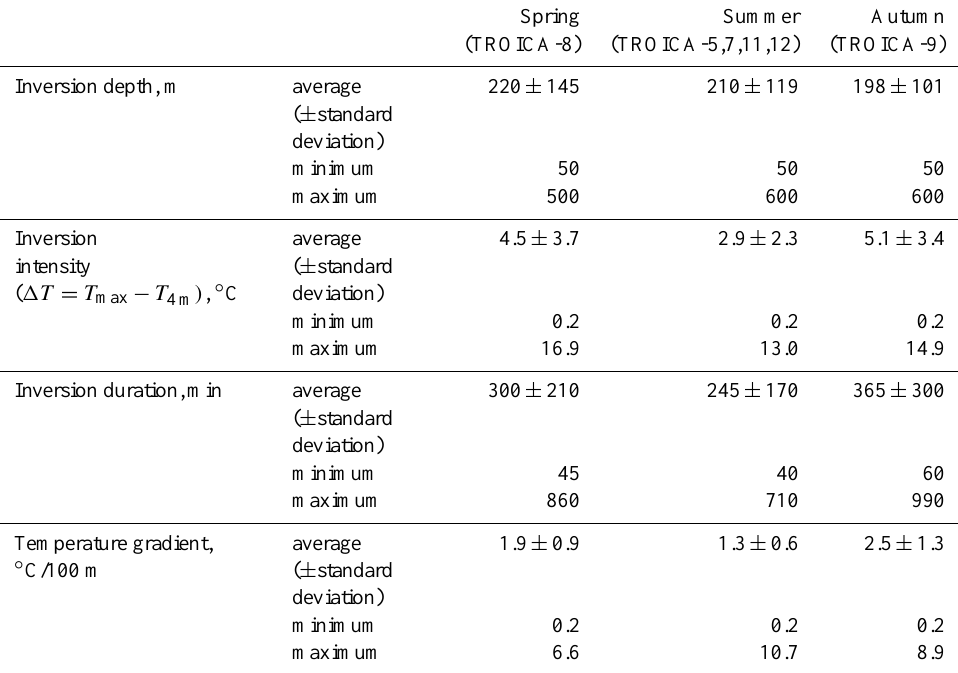
Table 2. Surface temperature inversion characteristics averaged in different